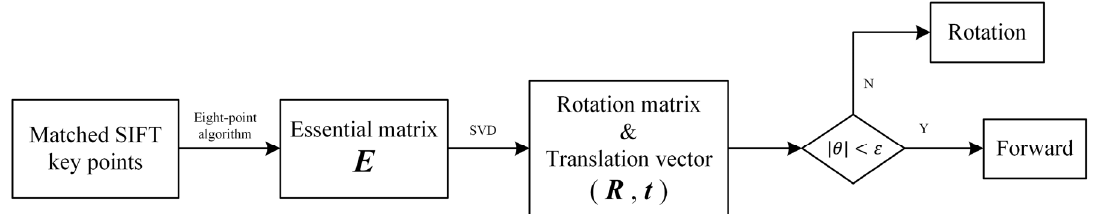
Figure 7. Flow chart of movement estimation based on SIFT. The essential matrix, E , is estimated by eight-point algorithm based on matched SIFT key points. The rotation matrix, R , and translation vector, t , are estimated by SVD. The movement type will be derived through the judgement block with the rotation angle, θ , and angle threshold, ε